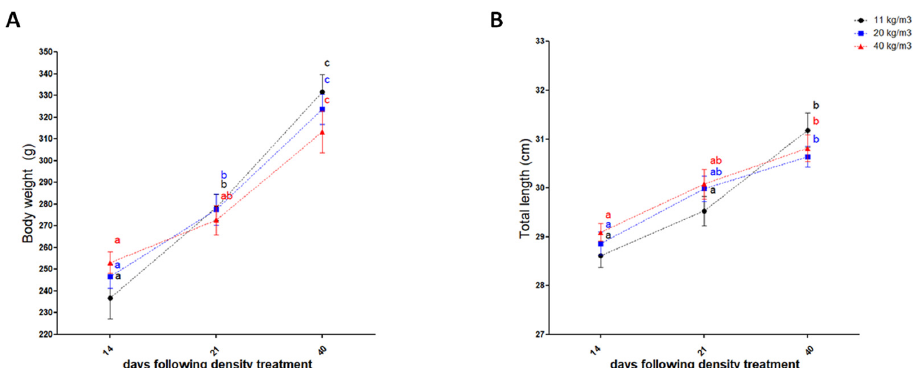
Figure 3. Effect of stocking density on S. salar smolt’s growth performance. Values of body weight ( A ) and total length ( B ) of post-smolts cultured at different initial stocking densities after 14, 21, and 40 days are expressed as mean ± SD ( n = 20). Different letters indicate significant differences between experimental groups ( p < 0.05, two-way ANOVA, followed by Tukey’s test).